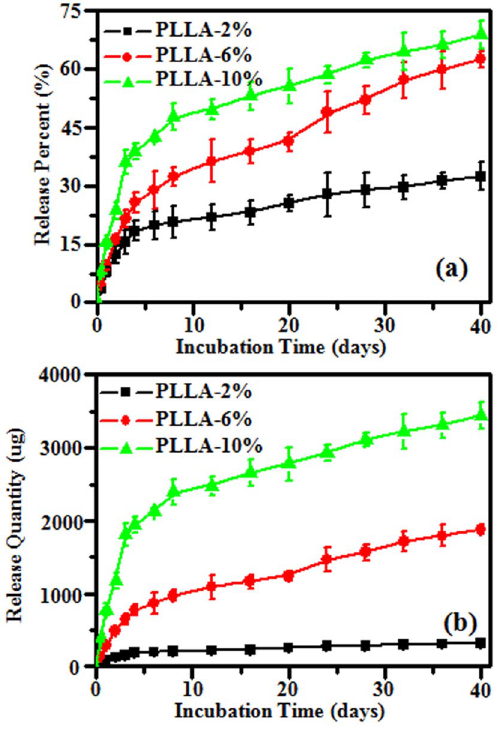
Figure 4. In vitro Rg3 release cumulative percentage (A) and cumulative quantity (B) from electrospun fibers after incubat- ing in PBS at 37 6 C.